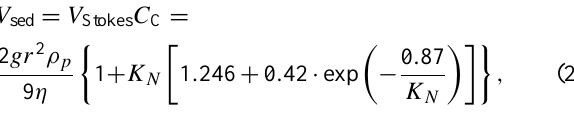
Fig. 3. Fitting surface for the correction factors for the immersion freezing process. Left: g 1 for SNAP-IT; right: g 2 for SNAP-OS. The dots are the original values, and the vertical bars indicate their deviation from the fitting surface. The degree of deviation is also indicated by the color of the dots: blue, green, and yellow represent less than 1, 2, and 3 standard errors, respectively, whereas red denotes greater than 3 standard error. The standard errors of fitting for the left and right panels are 0.83 and 0.04, respectively.